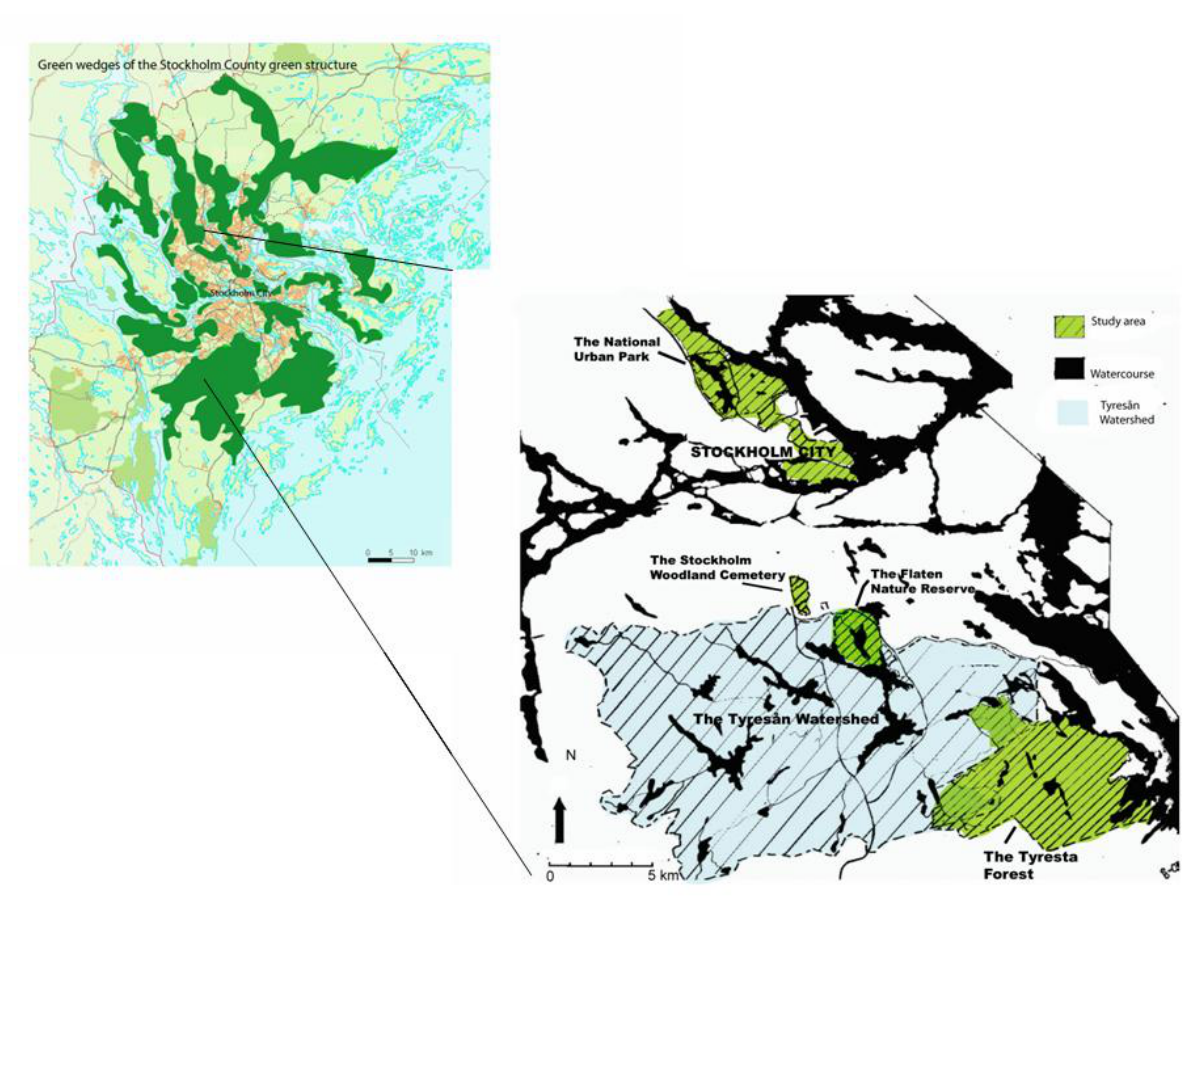
Fig. 1. The study area, consisting of the regional green structure of the Greater Stockholm Metropolitan Area and the five green spaces: the National Urban Park, the Stockholm Woodland Cemetery, the Flaten Nature Reserve, the Tyresta Forest and the Tyresån Watershed. (Ground map from the Office of Regional Planning and Urban Transportation, (online) URL: